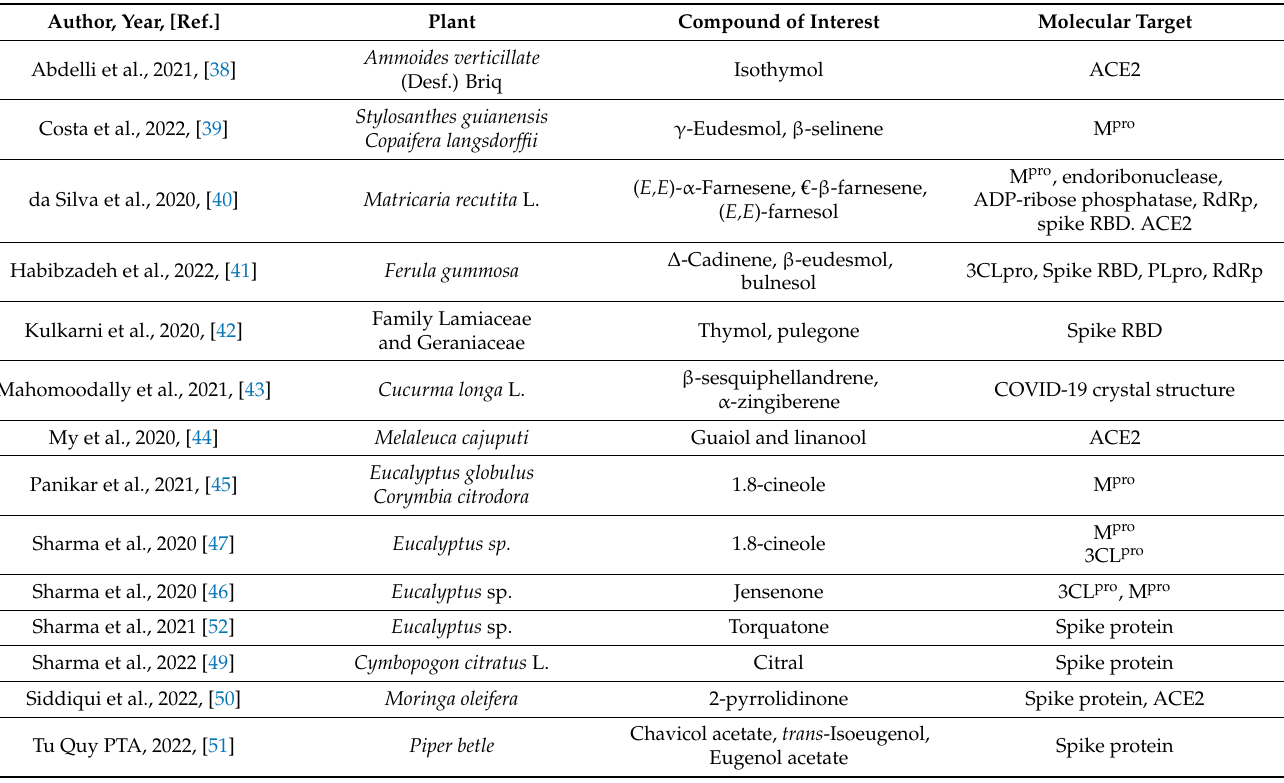
Table 4. SARS-CoV-2-related molecular targets used in molecular docking studies without in vitro